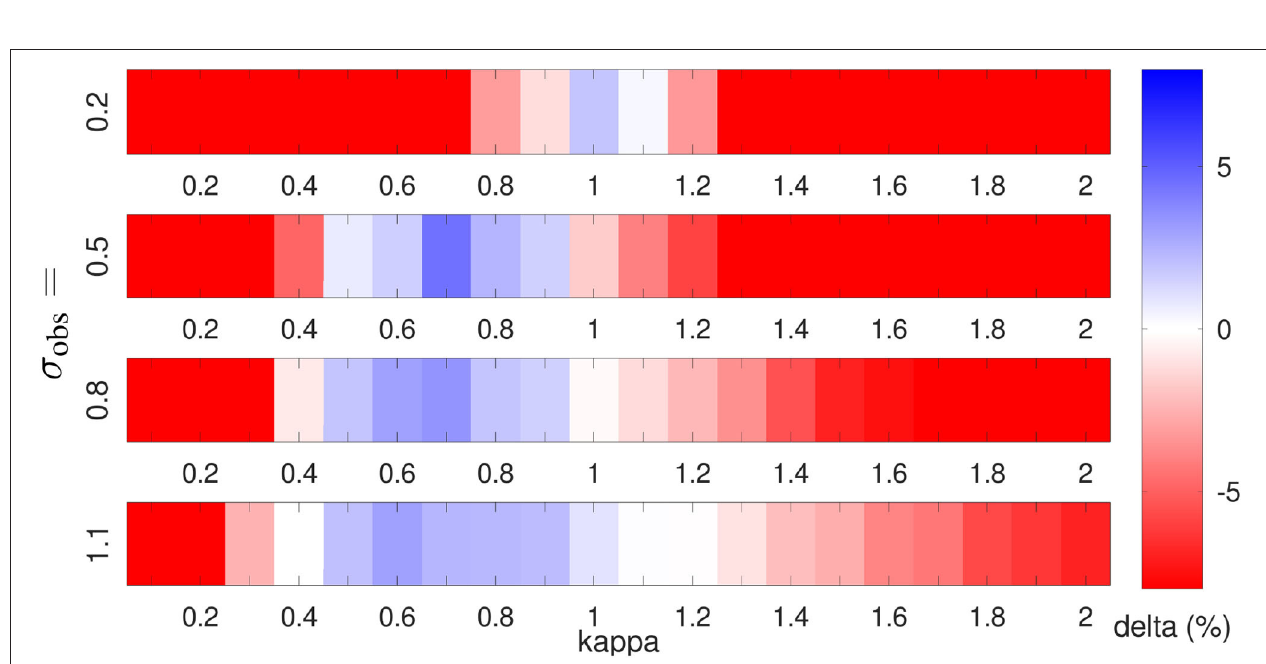
FIGURE 7 | Comparison of background errors of LMCPF and LETKF following Equation (121). Positive values denote a smaller RMSE of truth minus background for the LMCPF method than the LETKF. For each parameter combination, 1,000 data assimilation steps for the Lorenz 1996 model are carried out whereas the last 900 steps are used to compute the statistics. The experiments are repeated ten times with different seeds and the average error is reported. The true trajectory is generated with F true 8, the forecast length is set to 1 t 0.5 and the observation noise equals σ obs 0.5. Every second variable is observed. The ensemble size is = = = set to L 20 for both methods. =